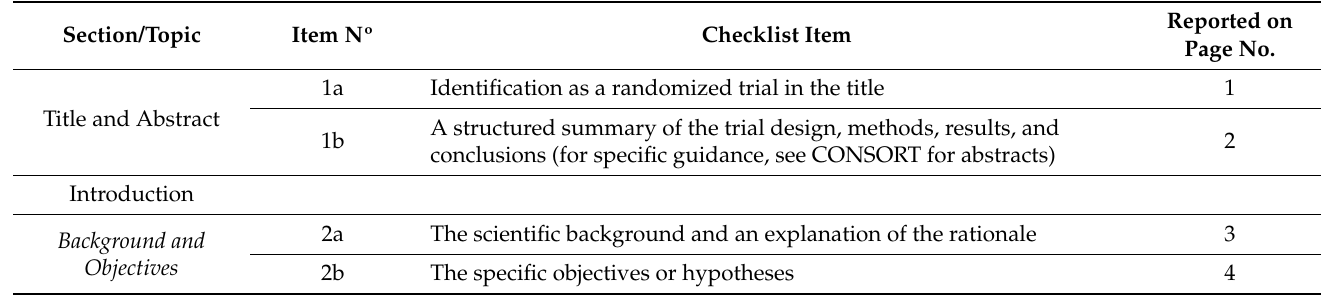
Table A1. The CONSORT 2010 checklist of information to include when reporting a randomized